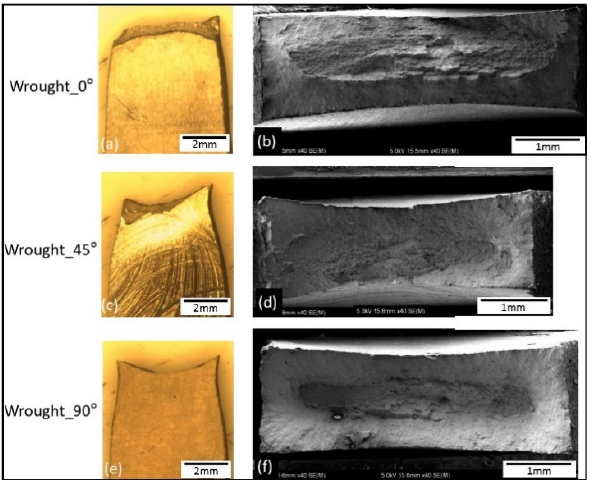
Figure 13. Macrographs showing side view of the tensile tested samples ( a , c , e ) and low magnification